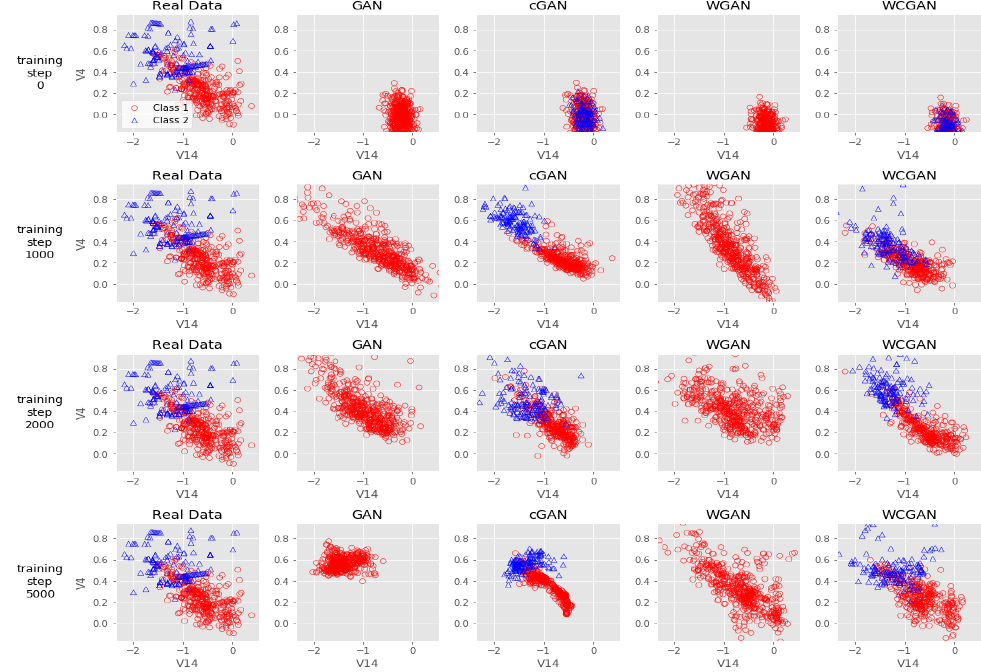
Figure 4. Comparison of GAN experiments ran on fraud data